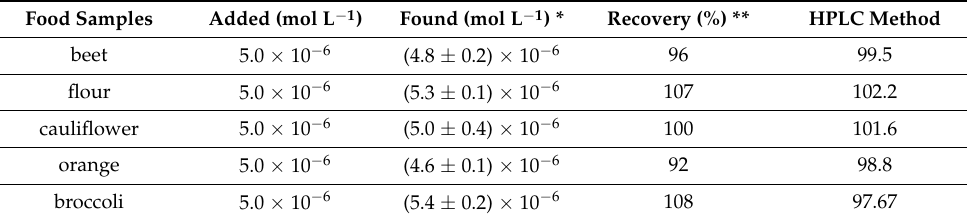
Table 2. Results obtained from the application of the proposed sensor for the detection and recovery of folate in different food samples.